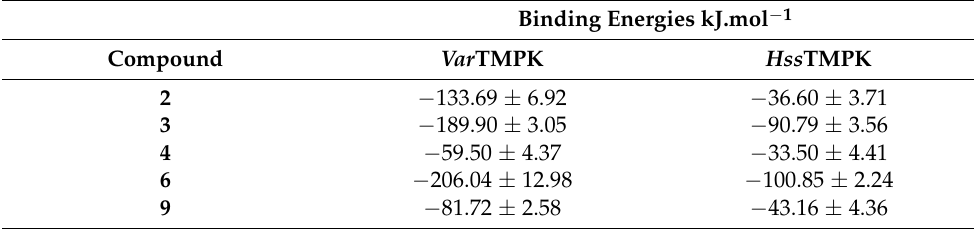
Figure 2. Best molecular docking poses for the prototypes inside Var TMPK and Hss TMPK: ( a ) Var TMPK/compound 1 , ( b ) Hss TMPK/compound 1 , ( c ) Var TMPK/compound 2 , ( d ) Hss TMPK/compound 2 , ( e ) Var TMPK/compound 3 , ( f ) Hss TMPK/compound 3 , ( g ) Var TMPK/compound 4 , ( h ) Hss TMPK/compound 4 , ( i ) Var TMPK/compound 5 , ( j ) Hss TMPK/compound 5 , ( k ) Var TMPK/compound 6 , ( l ) Hss TMPK/compound 6 , ( m ) Var TMPK/compound 7 , ( n ) Hss TMPK/compound 7 , ( o ) Var TMPK/compound 8 , ( p ) Hss TMPK/compound 8 , ( q ) Var TMPK/compound 9 , ( r ) Hss TMPK/compound 9 , ( s ) Var TMPK/compound 10 , ( t ) Hss TMPK/compound 10 . Table 4. MM-PBSA results for compounds 2 , 3 , 4 , 6 , and 9